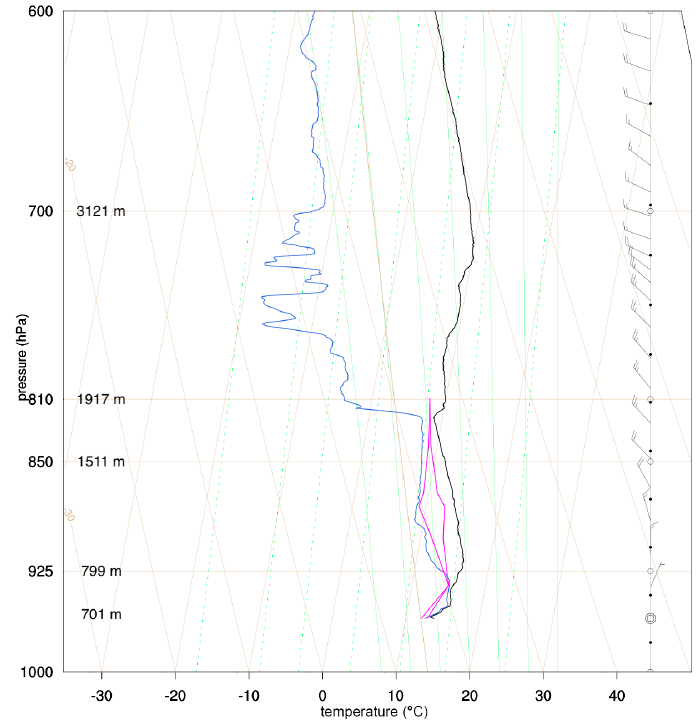
Figure 2. Skew-T diagram of the 0424 EST 19 August 2016 radiosonde profiles of temperature (black line) and dewpoint (blue line). Summit and Auto Road weather station temperatures and dewpoints (magenta lines) are shown for comparison. The 810 hPa isobar indicates the summit station pressure on this day.